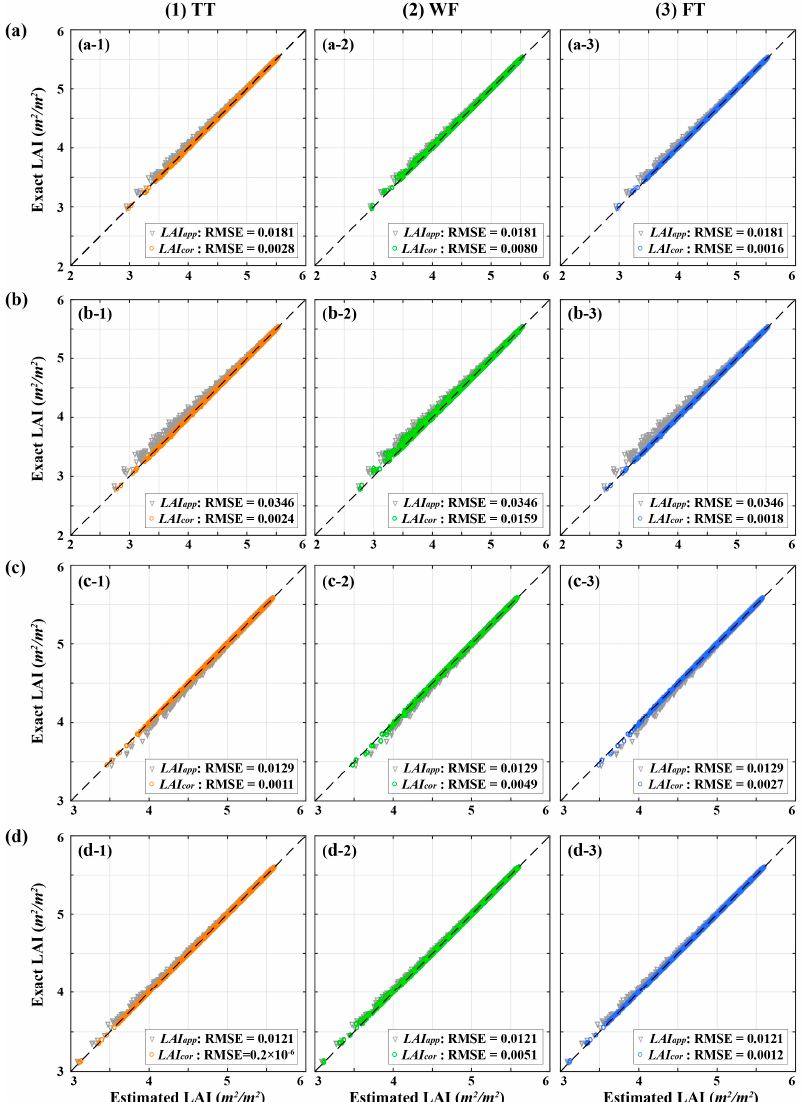
Figure 11. Correction of scaling bias with the four LAI estimation models at 32-m spatial resolution using the three techniques. The LAI estimation models are: ( a ) power model; ( b ) exponential model; ( c ) logarithmic model; and ( d ) polynomial model. The three techniques used to correct scaling bias are: ( 1 ) Taylor’s theorem (TT); ( 2 ) Wavelet-Fractal technique (WF); and ( 3 ) Fractal theory (FT). LAI app is the approximated LAI before correction, and LAI cor is the corrected LAI. The unit for RMSE is m 2 /m 2 .